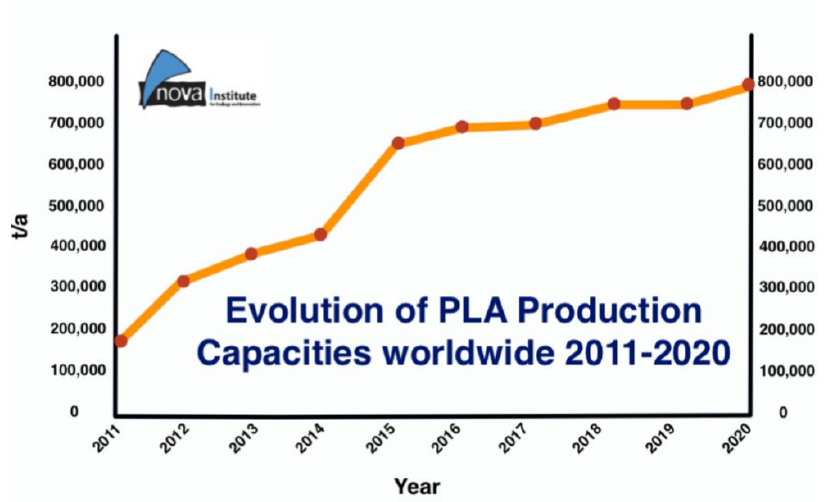
Figure 4. Global PLA market forecast, 2011 − 2020. Source: Nova Institute, [62].